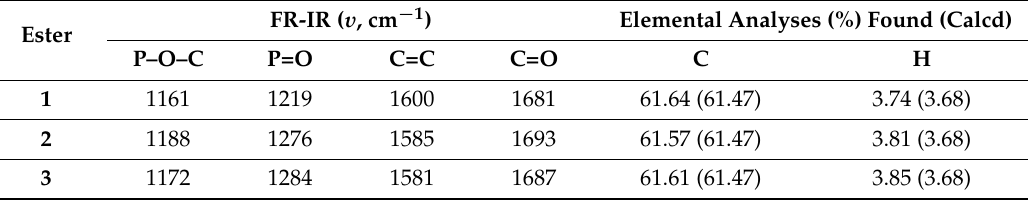
Table 1. Some FT-IR spectral data and elemental analyses for phosphate esters 1 – 3